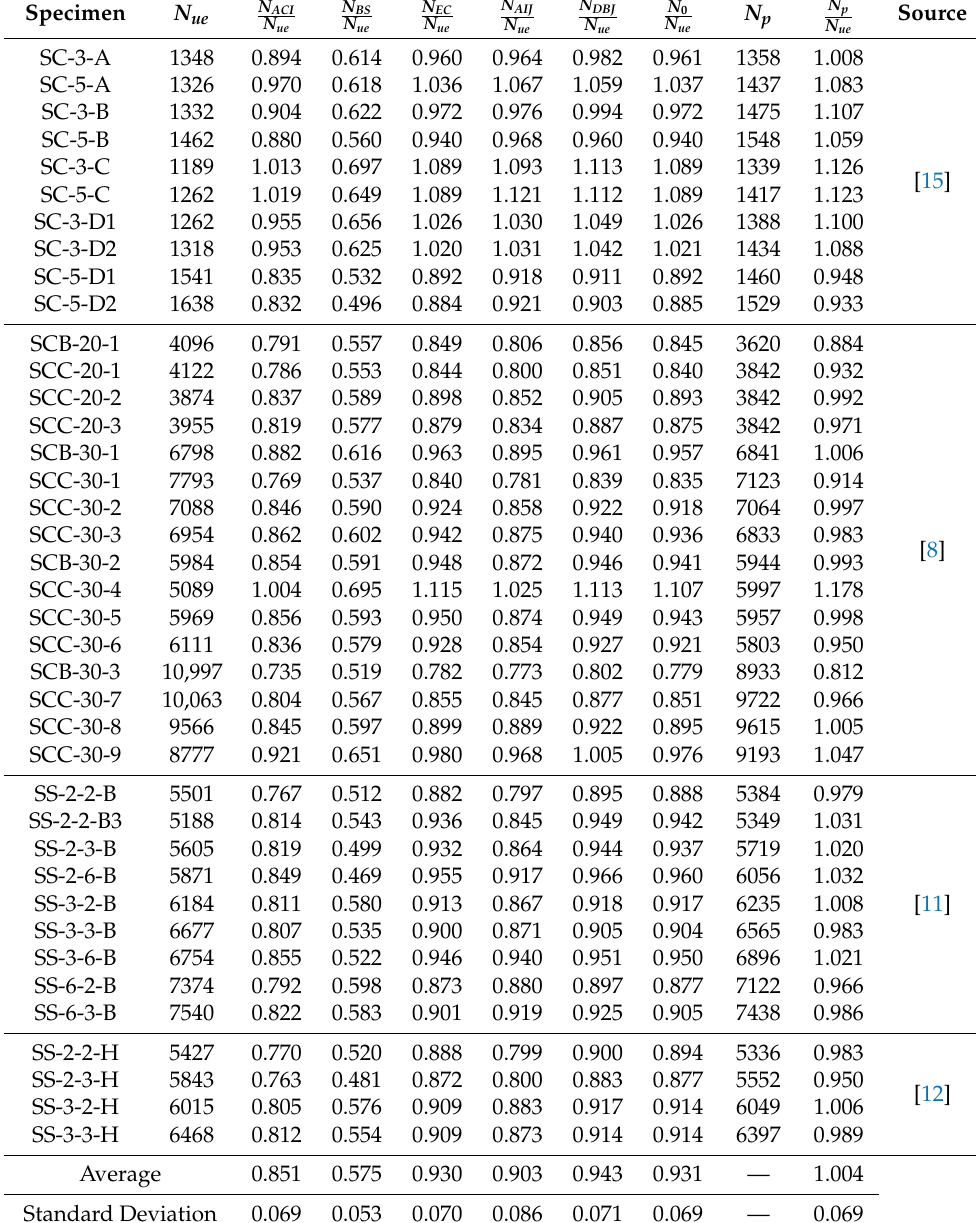
Table 3. Predicted values of bearing capacity of test